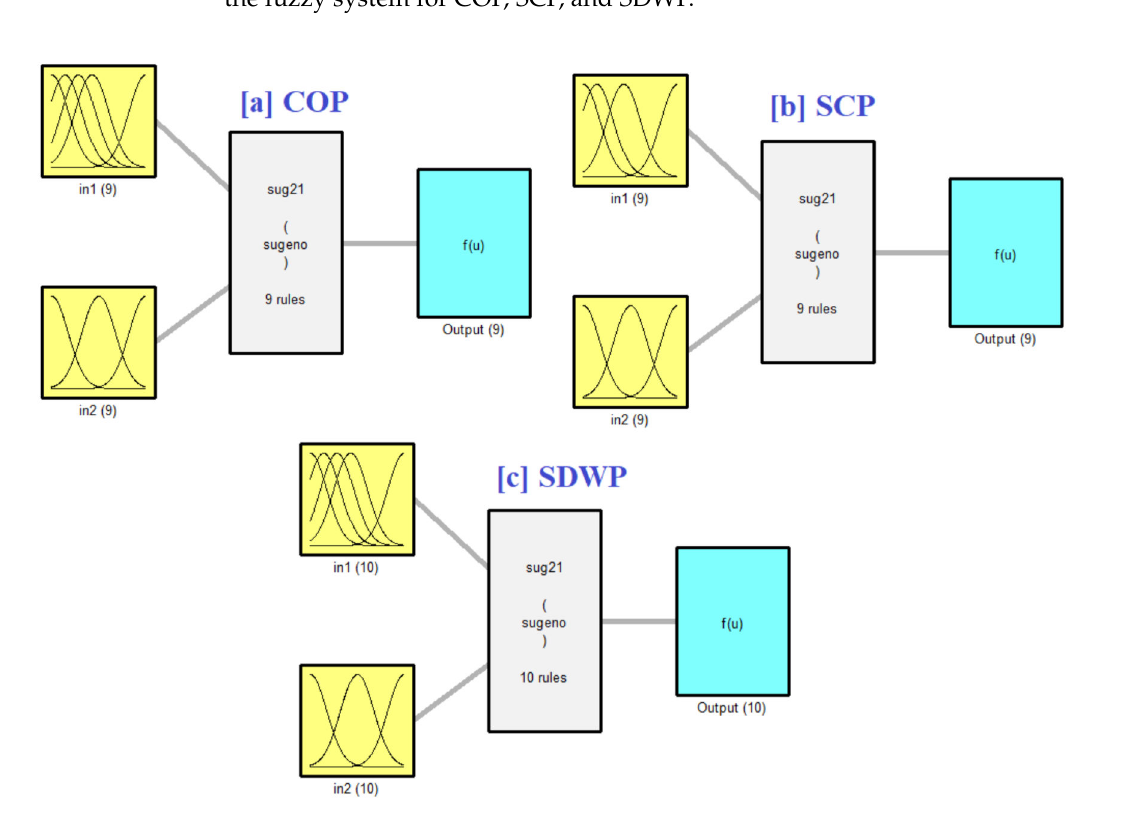
Figure 4. Inputs and outputs of ANFIS model ( a ) COP; ( b ) SCP, and ( c )